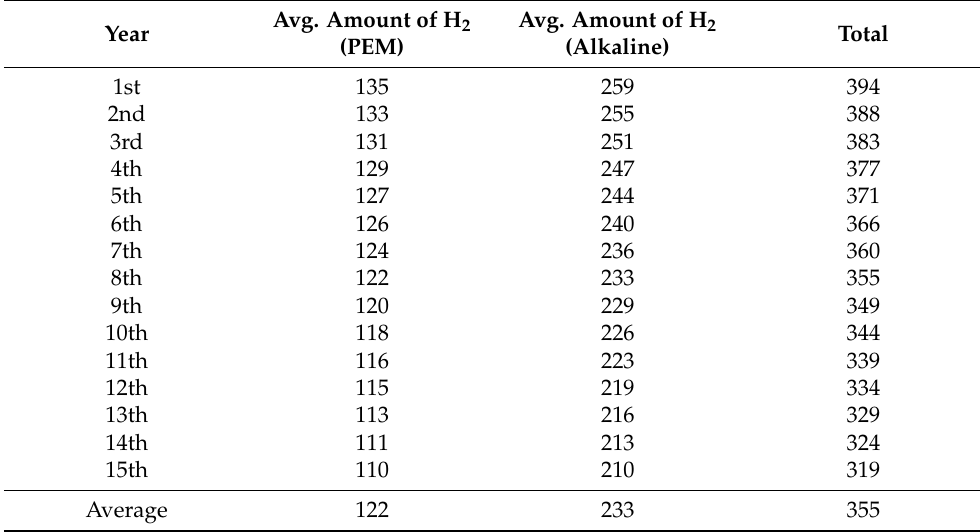
Table 34. The average daily amount of hydrogen produced for each year (Scenario